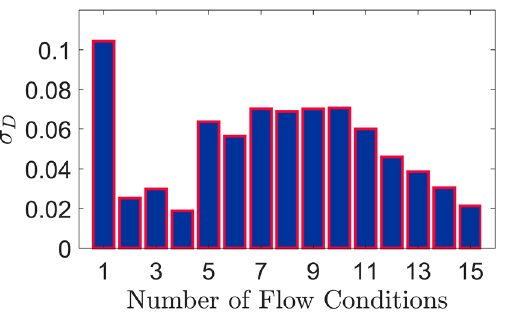
Figure 12. Standard deviation (σ D ) of the fractal dimensions evaluated using 1000 samples for each of the 15 flow test